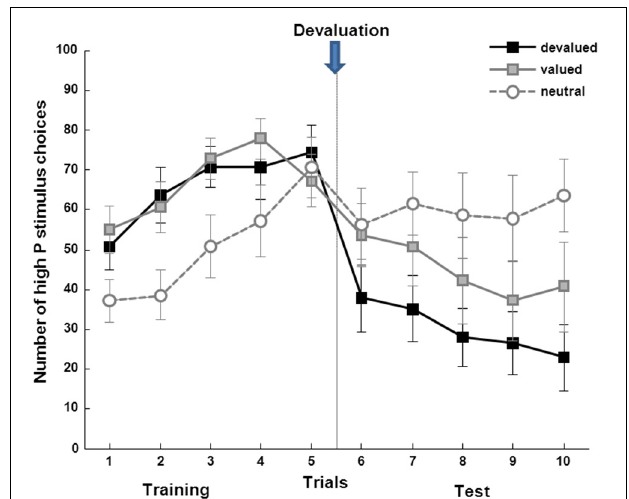
FIGURE 3 | Subjects learn to choose the high probability stimulus in all three conditions (devalued: T = − 3 . 50, p = 0 . 004, valued: T = − 2 . 60, p = 0 . 022; and neutral: T = − 2 . 73, p = 0 . 017), with a significant decrease of instrumental choice after devaluation only for the devalued stimulus ( T = 3 . 15, p = 0 .